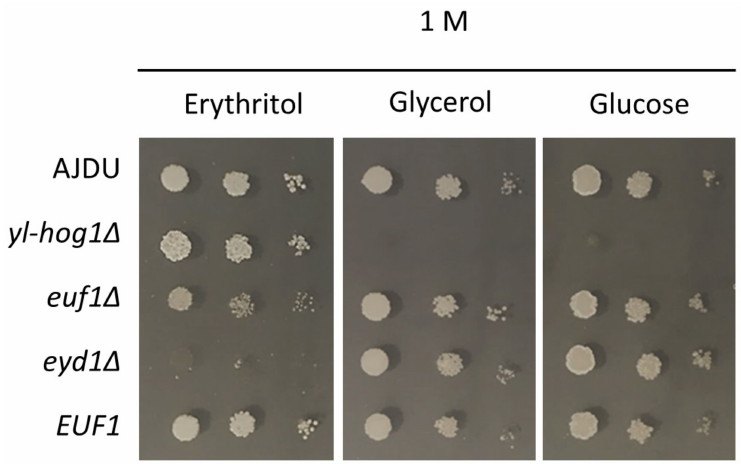
Figure 4. Growth of Y. lipolytica AJDU (control), yl-hog1 ∆ , euf1 ∆ , eyd1 ∆ , and EUF1 after 48 h of incubation on YNB agar plates with 1 M glycerol, glucose, and erythritol as the main carbon